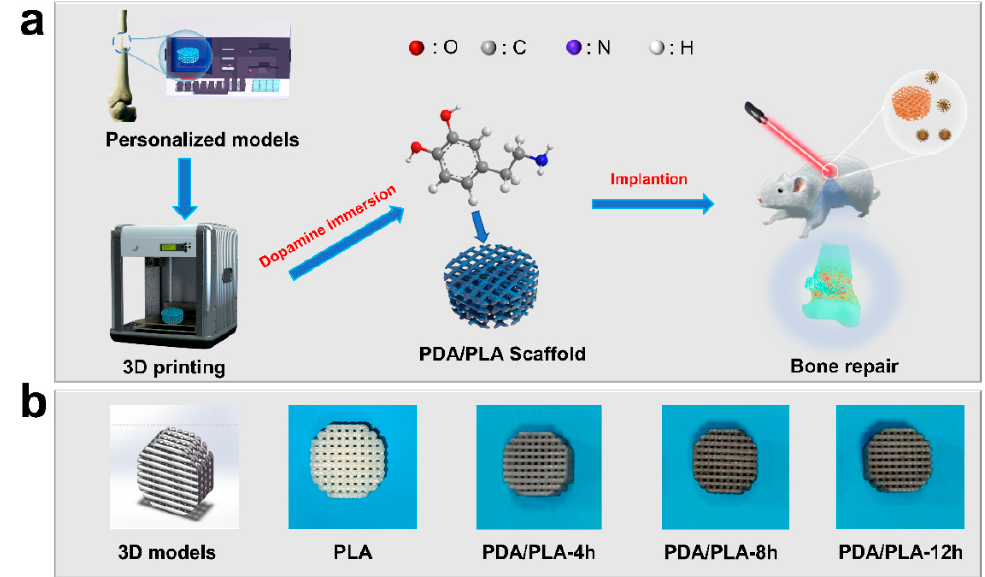
Figure 1. ( a ) Preparation process of PDA/PLA scaffolds, ( b ) 3D models of scaffolds and photographs of scaffolds prepared by immersion in PDA for different times.